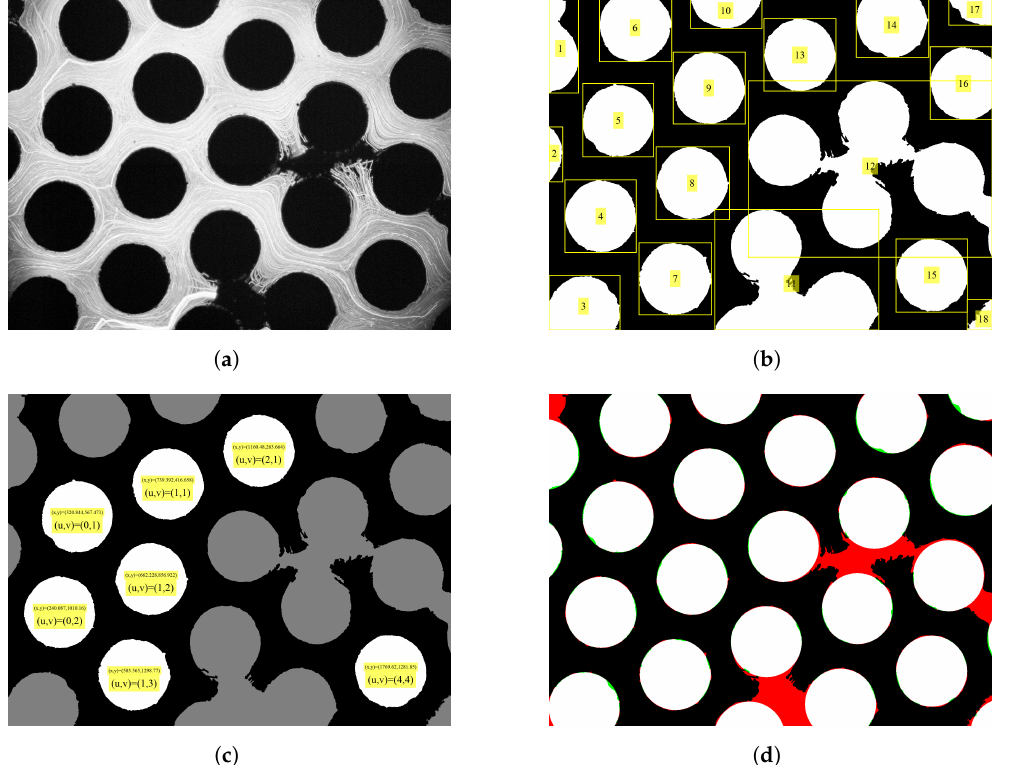
Figure 3. Conversion of an irregular range mask into a flaw-free solid mask: ( a ) a range image compiled from 7016 frames; several instances of snap-off are visible; ( b ) fine-tuned solid binary mask with its connected components labeled; ( c ) hand-selected solid grains, their centroid coordinates, and artificial integer indices; and ( d ) reconstruction from best-fit affine transformation; addition (green), deletion